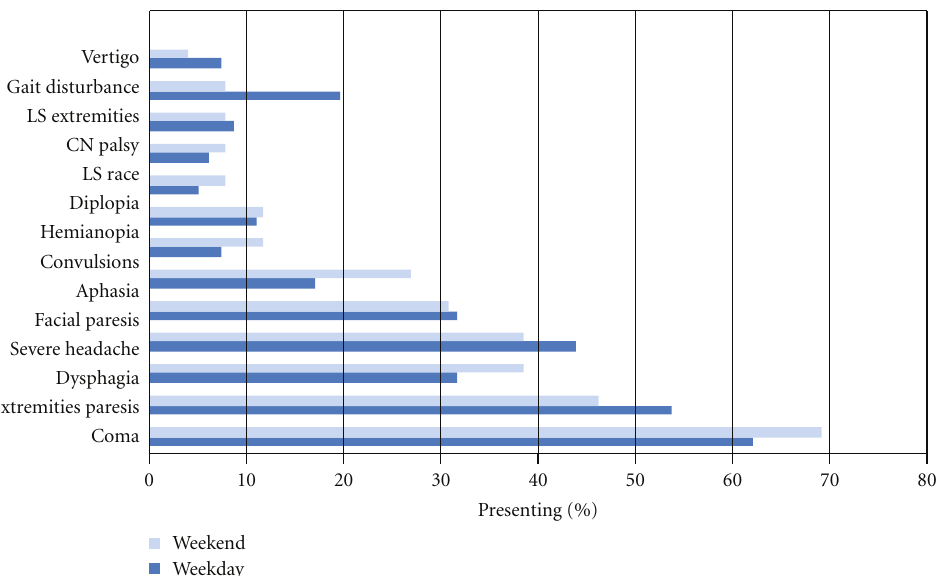
Figure 2: Di ff erences in percent of hemorrhagic strokes presenting with selected symptoms on weekends ∗ and weekdays in the atherosclerosis risk in communities (ARIC) study (1987–2004). Abbreviations: CN palsy: cranial nerve palsy; LS face: loss of sensation in face; LS extremities: loss of sensation in extremities. ∗ Weekend defined as any hospital arrival time from midnight Friday to midnight Sunday, † P < . 05 (two-sided chi-squared test for equal